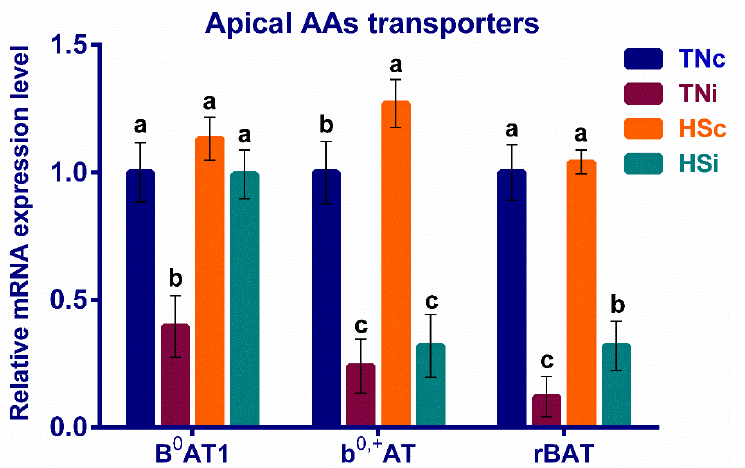
Figure 3. The mRNA fold expression of the ileal apical amino acid transporters at 6 dpi of E. maxima infected chickens raised under thermoneutral (TNi) and heat-stress (HSi) conditions, as compared to uninfected control chickens raised under thermoneutral (TNc) or heat-stress (HSc) conditions (N = 5). Assays were run in triplicate. RT-qPCR expression results were depicted as 2 −ΔΔCt . Significant differences ( p < 0.05) are depicted by different letters. The error bars represent the SEM.